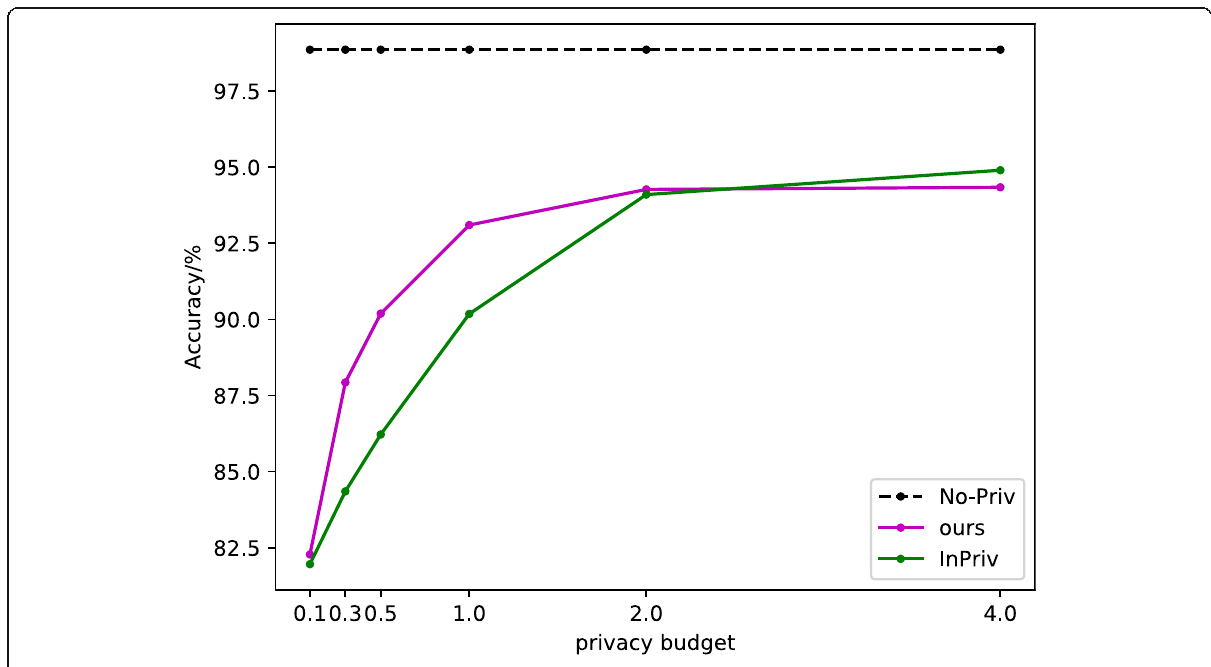
Fig. 6 The comparison of model performance on GSS